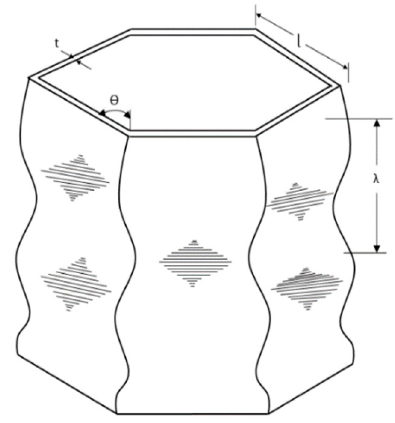
Figure 19. Elastic buckling of the hexagonal cell wall.